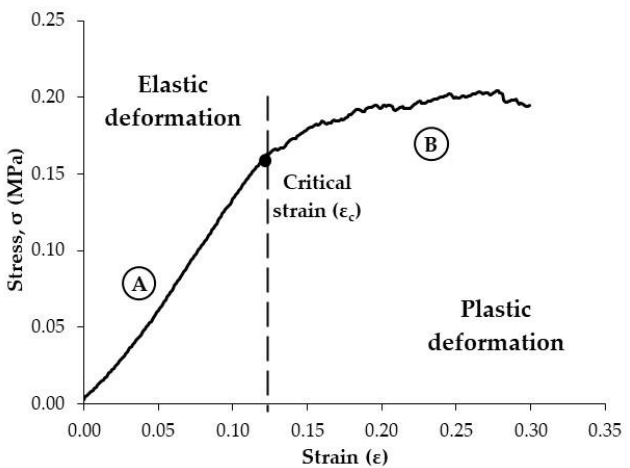
Figure 2. Averaged ( n = 30) stress – strain profile of commercial puffed corn cakes (PCC) when sub- jected to the flexion – compression test. Two zones are differentiated: ( A ) (elastic deformation) and subjected to the flexion–compression test. Two zones are differentiated: (A) (elastic deformation) and ( B ) (plastic deformation) bounded when the critical strain is reached. (B) (plastic deformation) bounded when the critical strain is